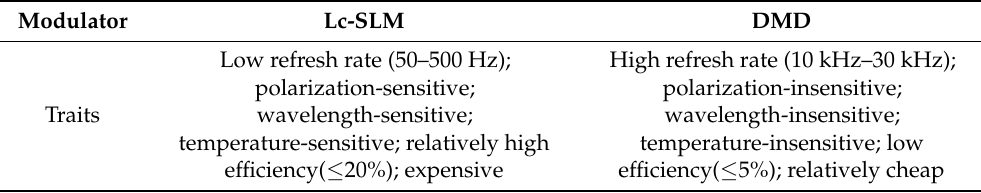
Table 1. Comparison of Lc-SLM and DMD for structured light